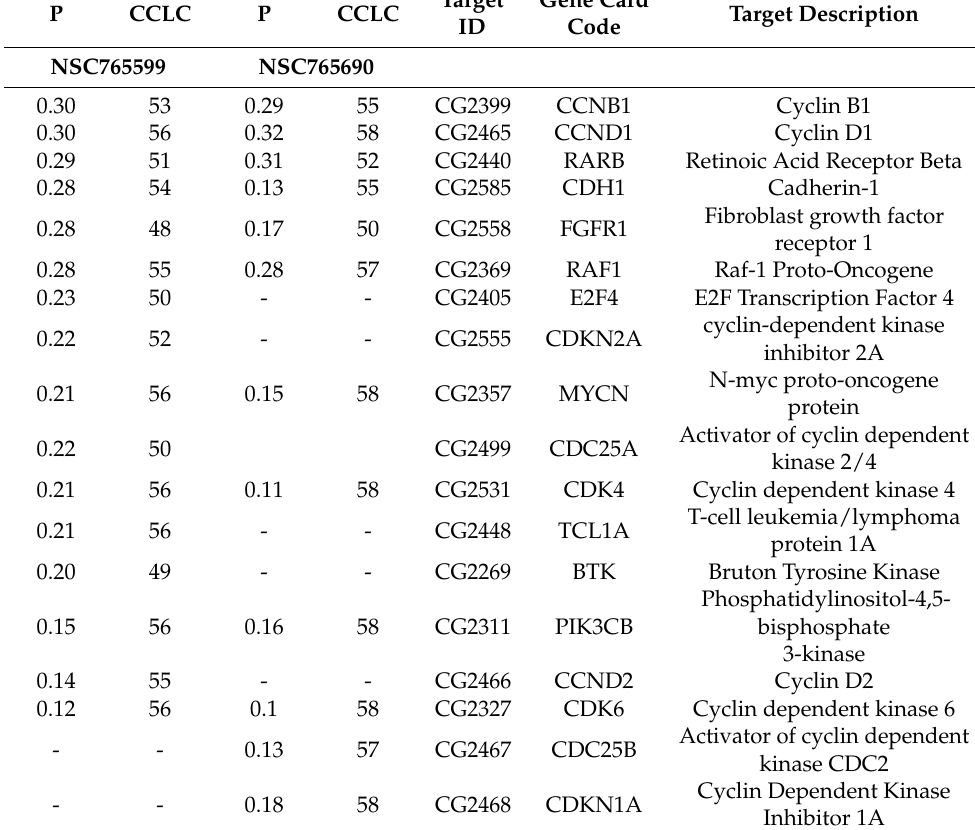
Table 3. Molecular targets correlated to NSC765599 and NSC765690 activity.